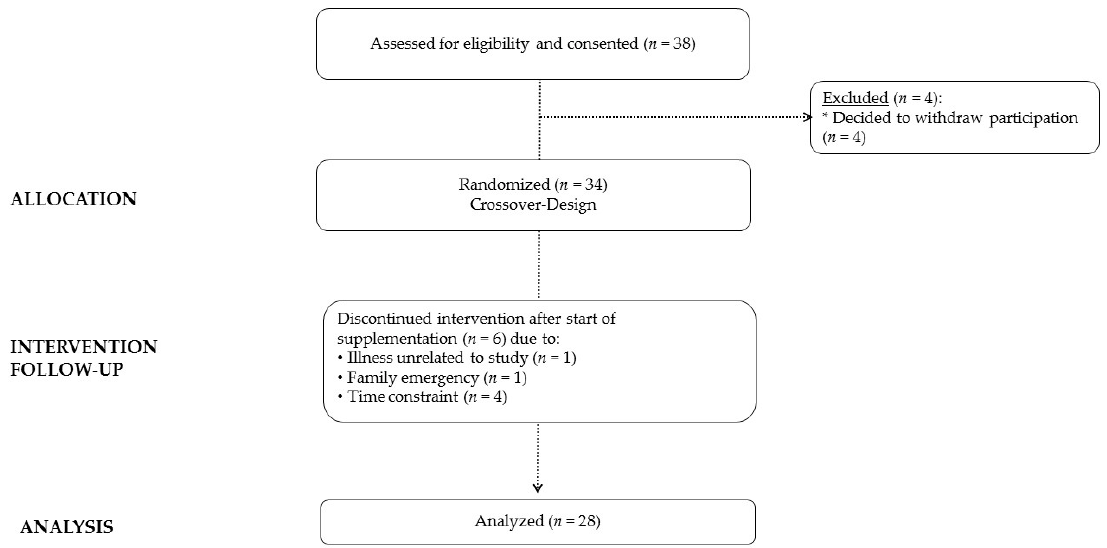
Figure 3. CONSORT Figure 3. CONSORT diagram.